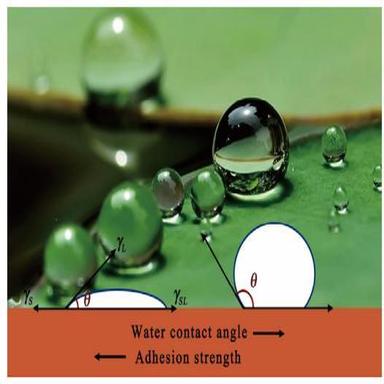
Schematic diagram showing the interaction between WCA and adhesion strength.